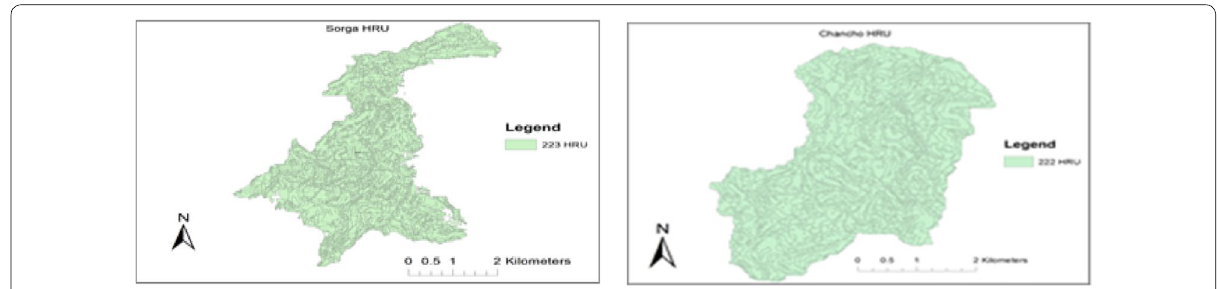
Fig. 4 Map of hydrological response